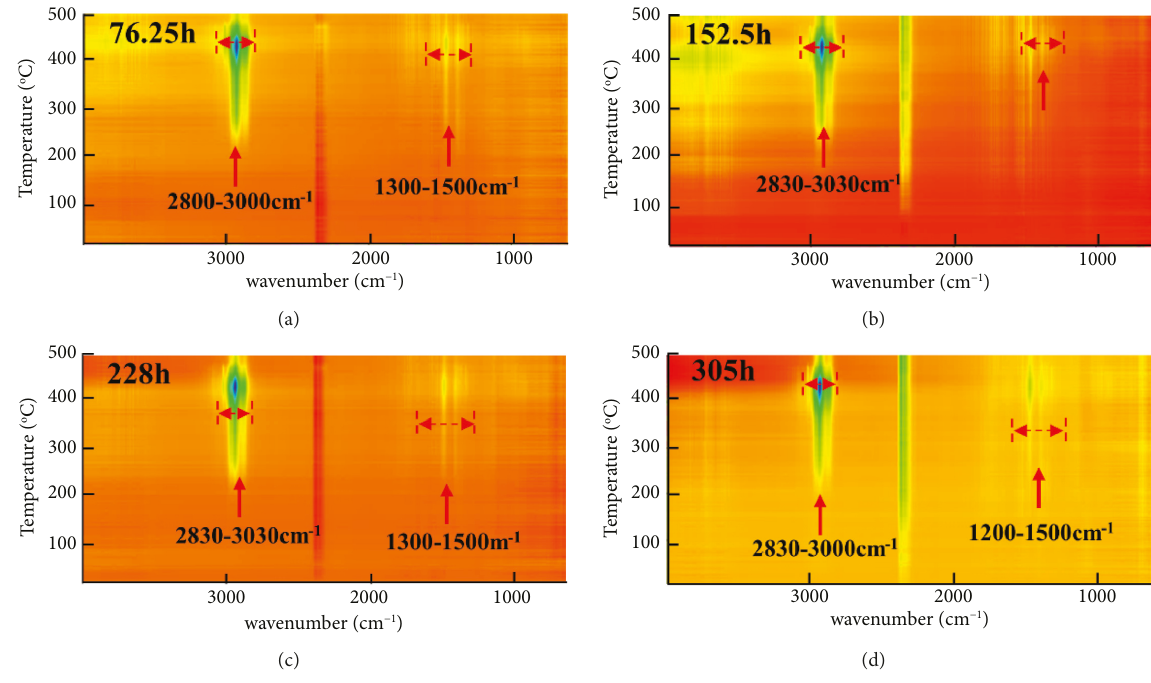
Figure 14: 2D spectrogram of ASA-modified asphalt at different UV aging stages. (a) 76.25h-2D. (b) 152.5h-2D. (c) 228h-2D. (d)